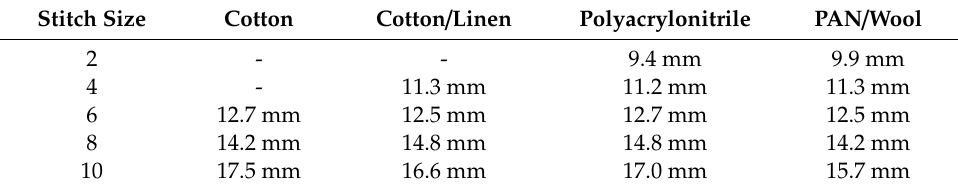
Table 4. Stitch lengths of knitted fabrics under examination in this study.